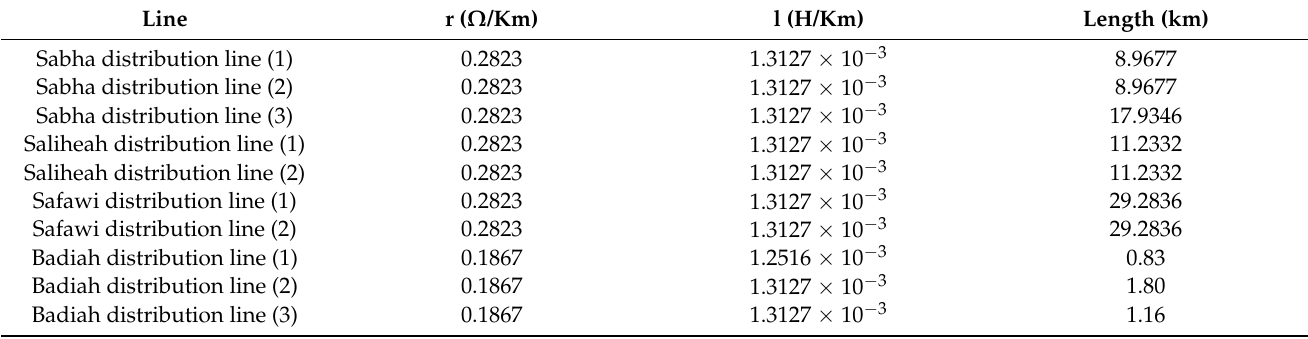
Table 4. Line Data in